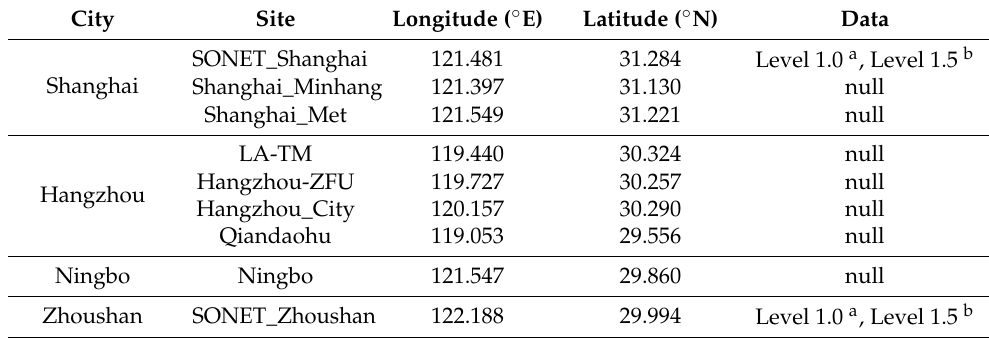
Table 1. Data from AERONET AOD stations in SHB in 2016. City Site Longitude ( ◦ E) Latitude ( ◦ N)